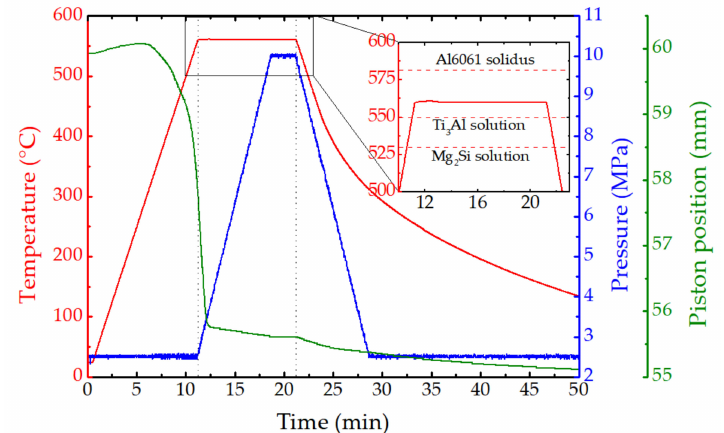
Figure 2. The course of temperature, piston pressure and piston position during the sintering